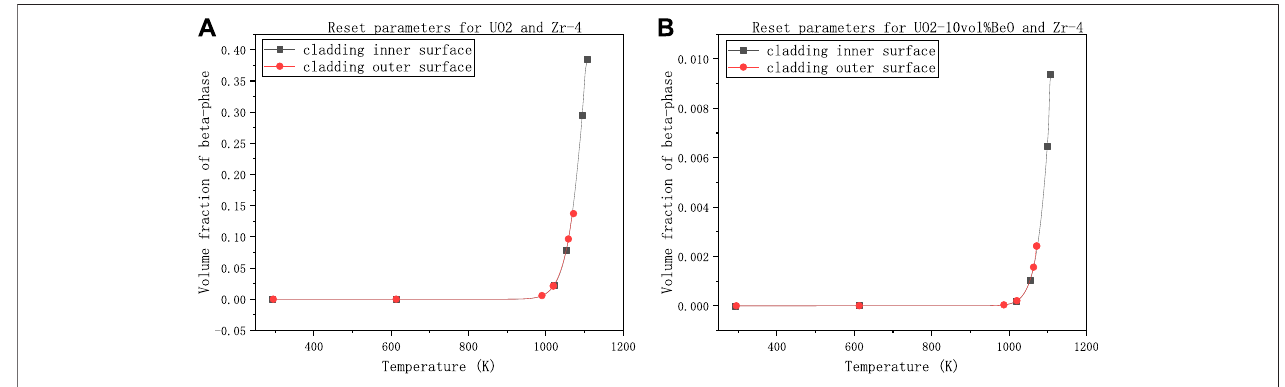
FIGURE7| Volume fraction of β -phase oncladding inner and outersurface withpower linearrate60,000 W/m, gap size1e – 7 m, temperature at theextremities of fuel element 1500 K and the number multiplying the heat transfer coef fi cient 0.4, (A) for UO 2 and Zircaloy-4, (B) for UO 2 -10vol%BeO and Zircaloy-4.